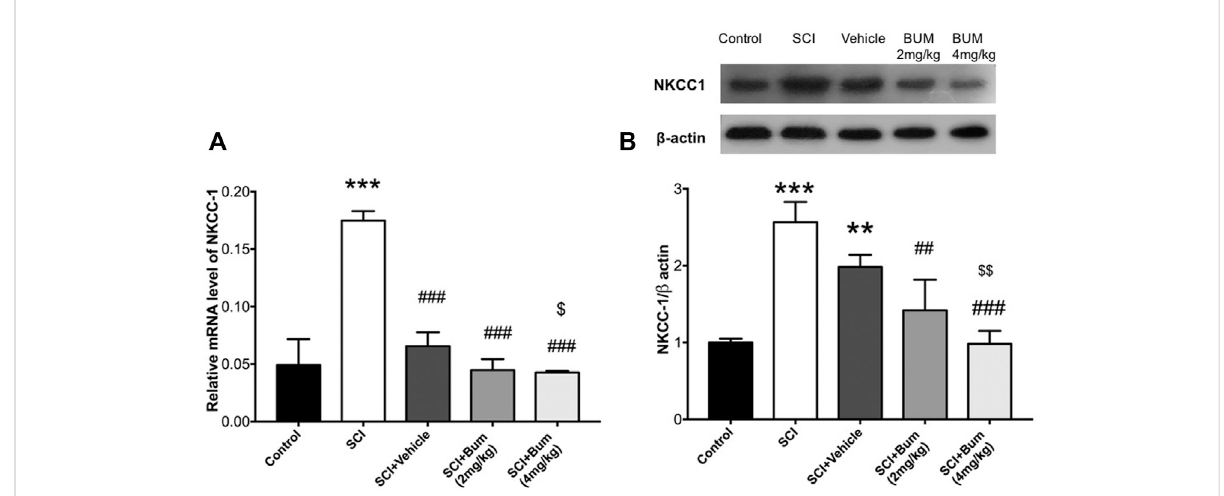
FIGURE 4 Bumetanide suppresses NKCC1 expression. (A) NKCC1 gene expression levels of the injured spinal cord at 4 weeks after SCI. Related gene expression levels were upregulated at the SCI group, and Bum 4 mg/kg treatment decreased the NKCC1 expression compared to the vehicle. (B) Representative Western blots of and quantitative data for NKCC1 and b-actin expression in each SCI group. NKCC1 protein expression level was decreasedbybumetanidetreatment.** p ≤ 0.01,*** p ≤ 0.001vs.controlgroup;## p ≤ 0.01,### p ≤ 0.001vs.thetreatedSCIgroup.$ p ≤ 0.05, $$ p ≤ 0.01 vs. vehicle group. Data are presented as the mean ± S.D. Loading controls were reused across Figures 4 and 5 of this article.